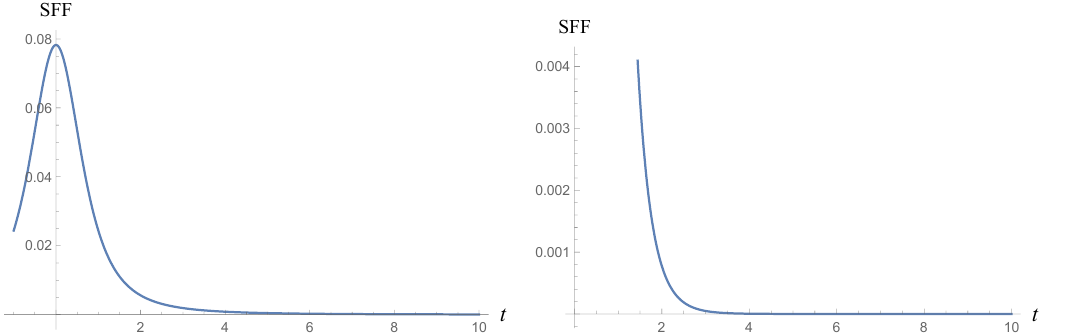
Figure 6 . Left: the SFF from the topology of two disconnected disks for (cid:22) = 1 ; (cid:12) = 1 as a function of the time t . Right: the non-perturbative disconnected SFF exhibiting again a decay at late